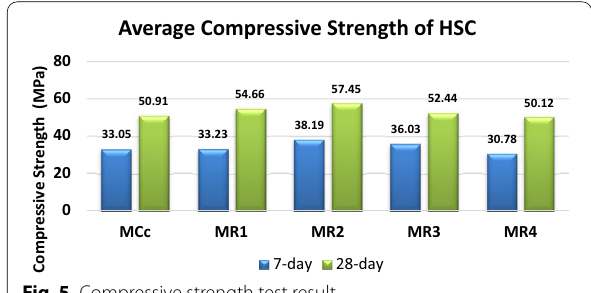
Fig. 5 Compressive strength test